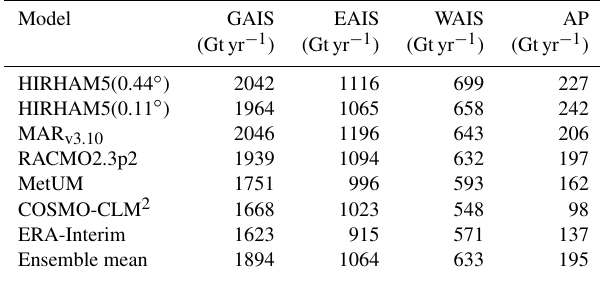
Table A1. Mean annual SMB for the grounded ice sheet over the total (GAIS), the East Antarctic (EAIS), West Antarctic (WAIS), and Antarctic Peninsula (AP) regions over the common mask for the common 1981–2016 period, where all the models overlap (ex- cept COSMO-CLM 2 , which is shown for 1987–2015). The ensem- ble mean is calculated only from models that cover the full period and therefore excludes the COSMO-CLM 2 results but includes the driving ERA-Interim model. SMB here is calculated using the sim- ple Eq. (1) to enable a fair comparison. We used the Rignot et al. (2019) definitions for the different regions of